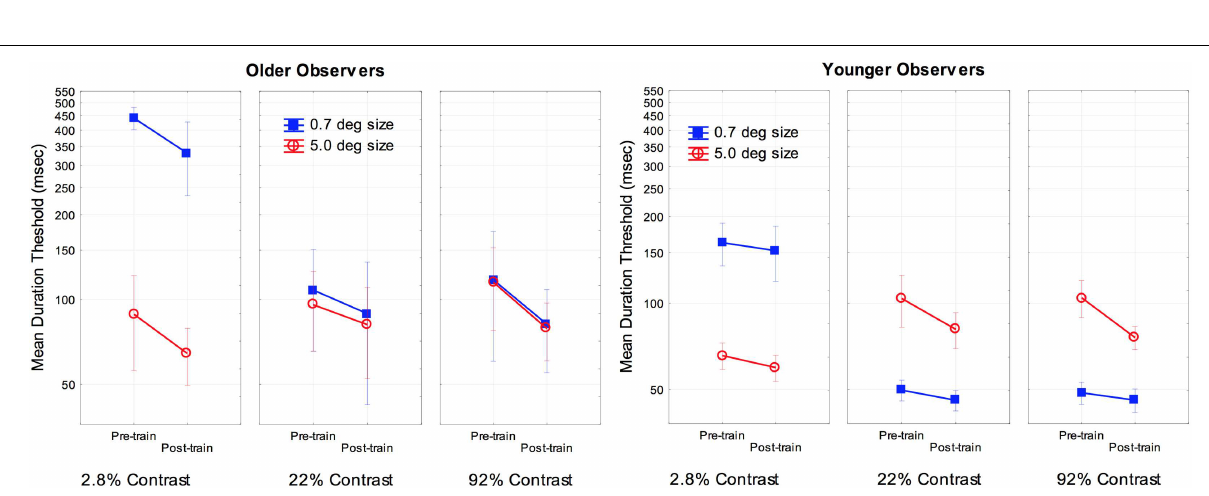
a 23% improvement for the most difficult conditions (small-size and